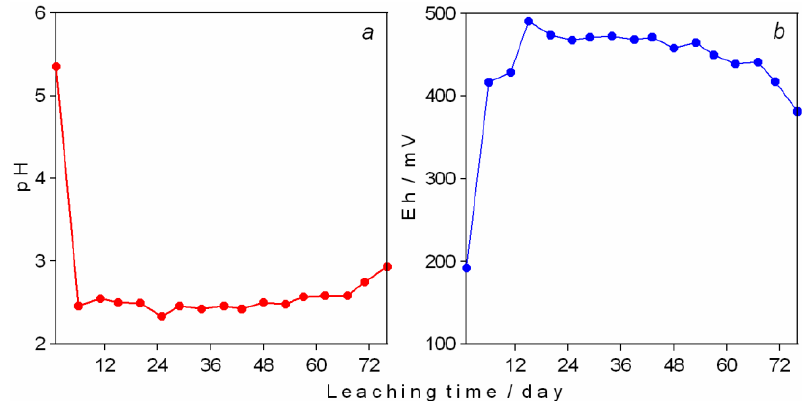
Figure 4. Changes of pH ( a ) and redox potential ( b ) in the solutions after filtration. Correlation of ferrous and ferric iron concentrations in the solutions after filtration in a percolator indicates the oxidation of Fe 2+ (Figure